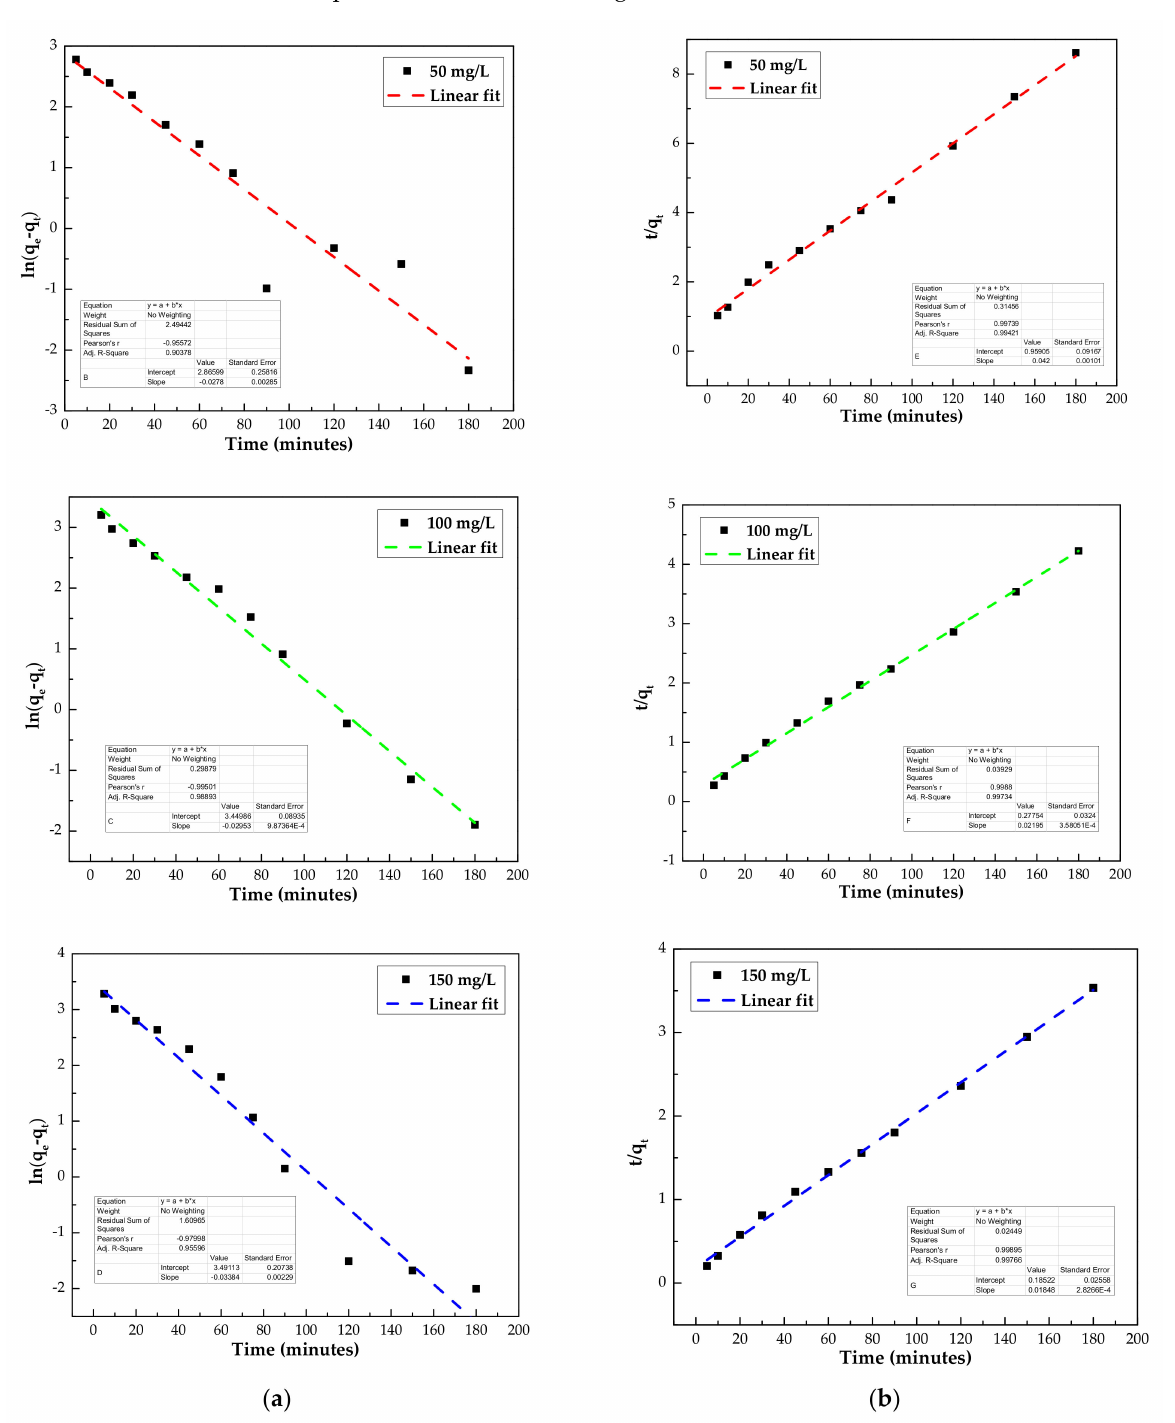
Figure 13. Kinetics plots for adsorption of phenol by IL–agar–alginate beads at 25.0 ◦ C (using pseudo-first order model (PFO) ( a ) and pseudo-second order model (PSO) ( b )) at different initial concentrations of